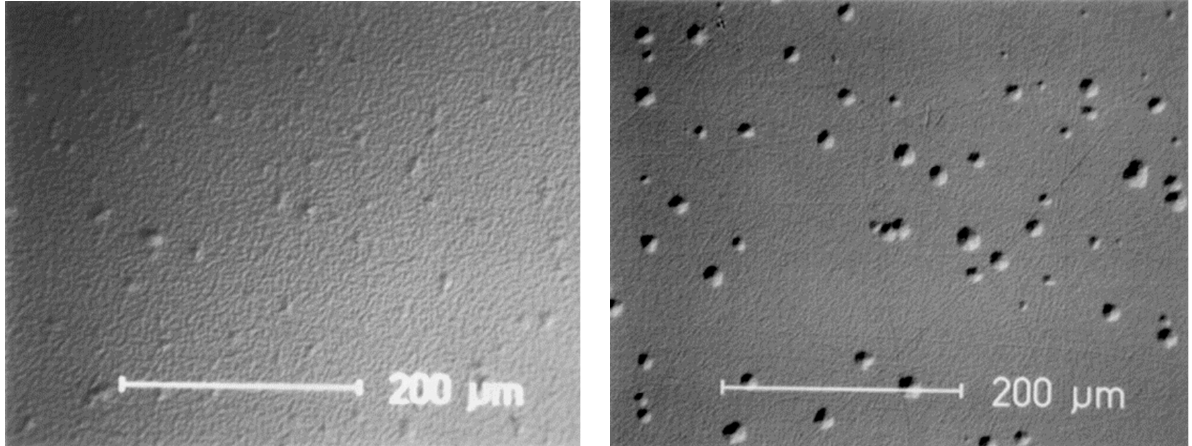
Figure 21. Cross-sectioned polished surface after hydrothermal treatment for 48 h ( left : coating technology, right : co- precipitation).